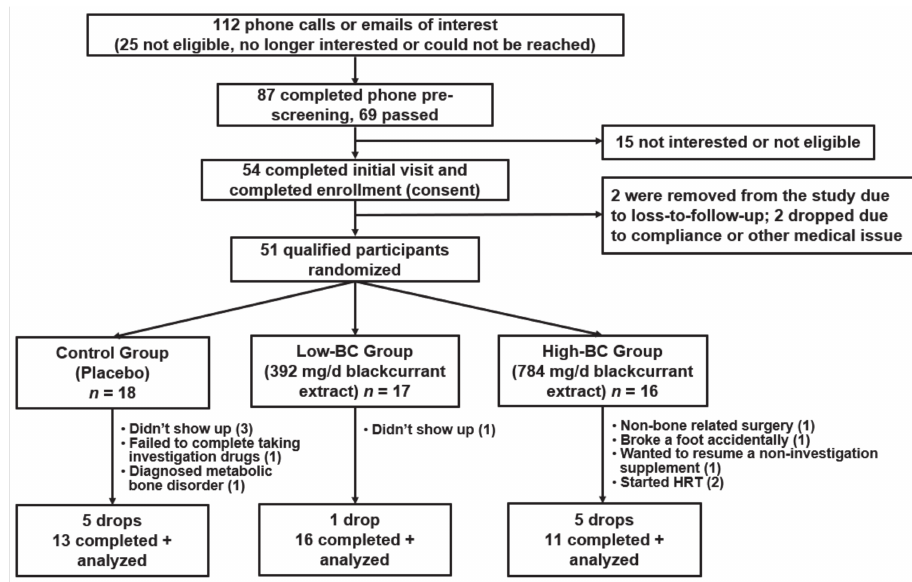
Figure 1. Inclusion and follow-up of the study participants. Final analysis n = 40. Table 1. Baseline characteristics (mean, SD) of study participants a